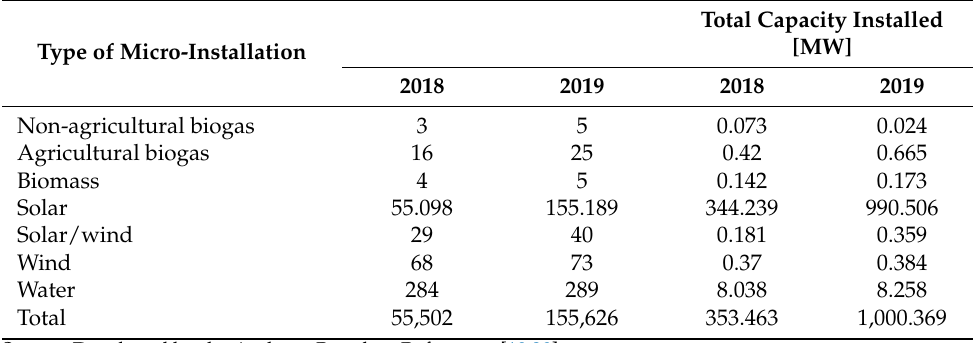
Figure 3. Domestic electricity production and consumption in Poland in 2006–2019 [GWh]. Source: developed by the authors, based on Reference [15]. Table 1. Number of micro-installations and total installed capacity in